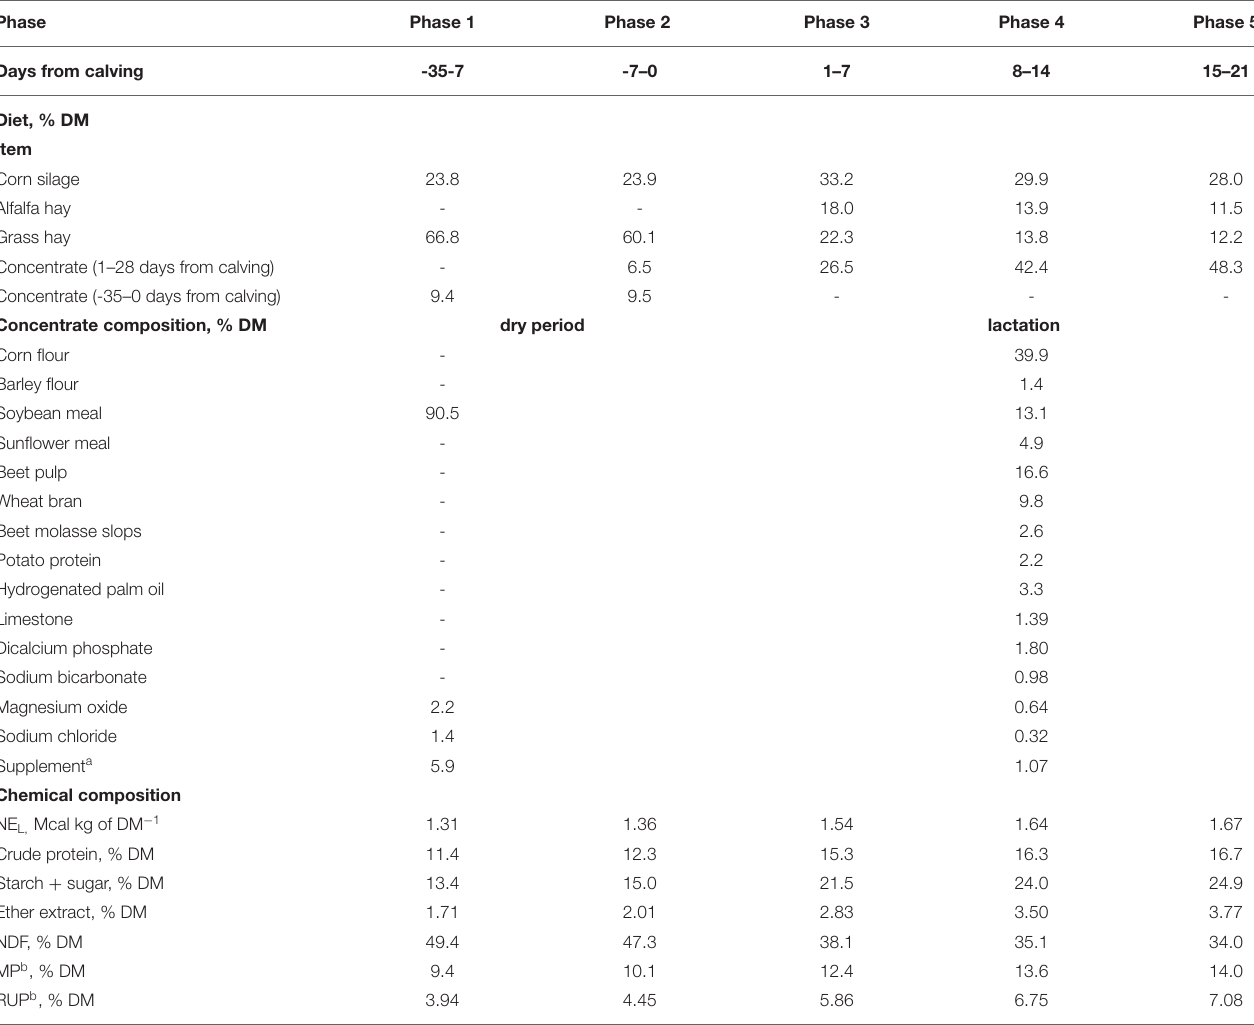
TABLE 1 | Composition and characteristics of the experimental diets fed to cows during the 5 experimental